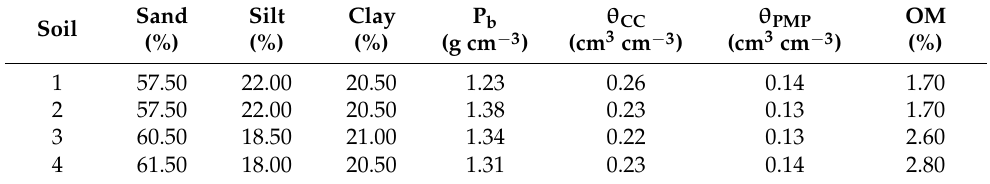
Table 1. Physical properties of the study soils.